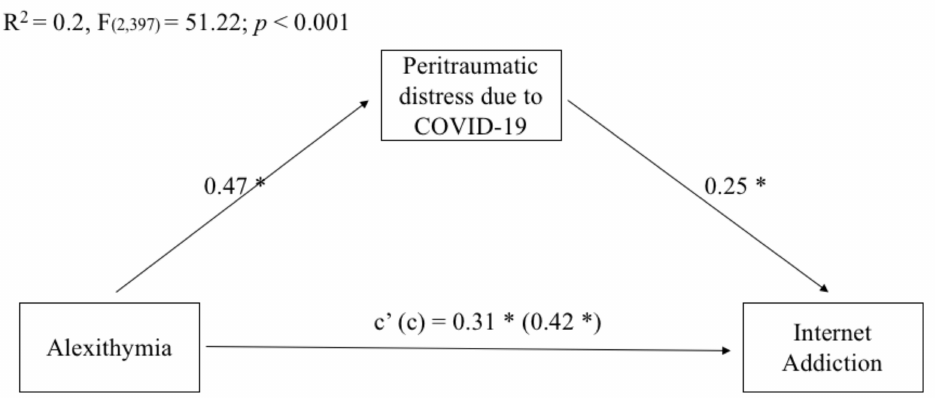
Figure 2. Mediation of emerging adults’ peritraumatic distress due to COVID on the relationship between their levels of alexithymia and Internet addiction. Coefficients shown are standardized path coefficients. c’ = direct effect; c = total effect. * p <